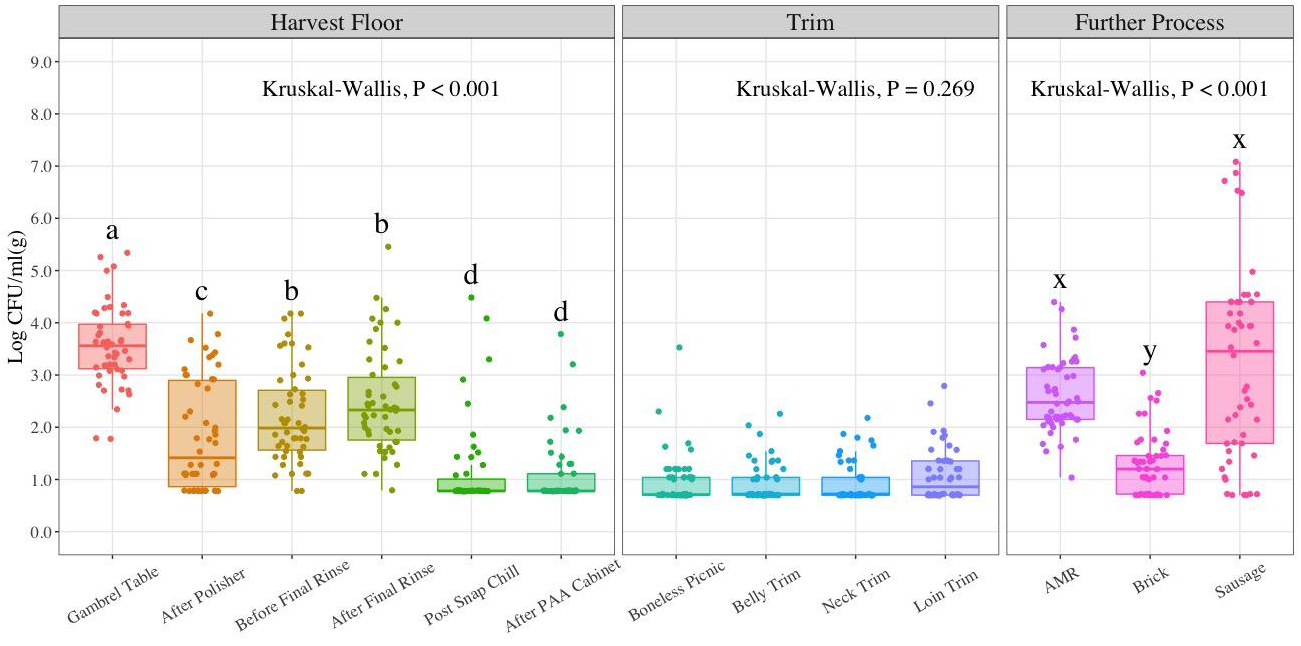
Figure 3 . Enterobacteriaceae (EB) counts in LogCFU/mL (g) at each processing stage throughout the pork processing line ( n = 50; N = 650). The LOD at harvest is 6 CFU/mL (0.78 LogCFU/mL); for trim and further process samples 5 CFU/g (0.70 LogCFU/g). In the boxplot, the horizontal line crossing the box represents the median, the top and bottom lines represent the lower (0.25) and upper (0.75) quartiles, the vertical top lines represent 1.5 times the interquartile range and the vertical bottom line represents 1.5 times the lower interquartile range. The dots represent actual data points. Box plots with different letters (a – d); (x – z) represent statistical significant differences according to Krus- kal – Wallis analysis followed by pairwise comparison with Wilcoxon’s test at p -value < 0.05. PAA (Peroxyacetic acid); AMR (Advanced Meat Recovery) .